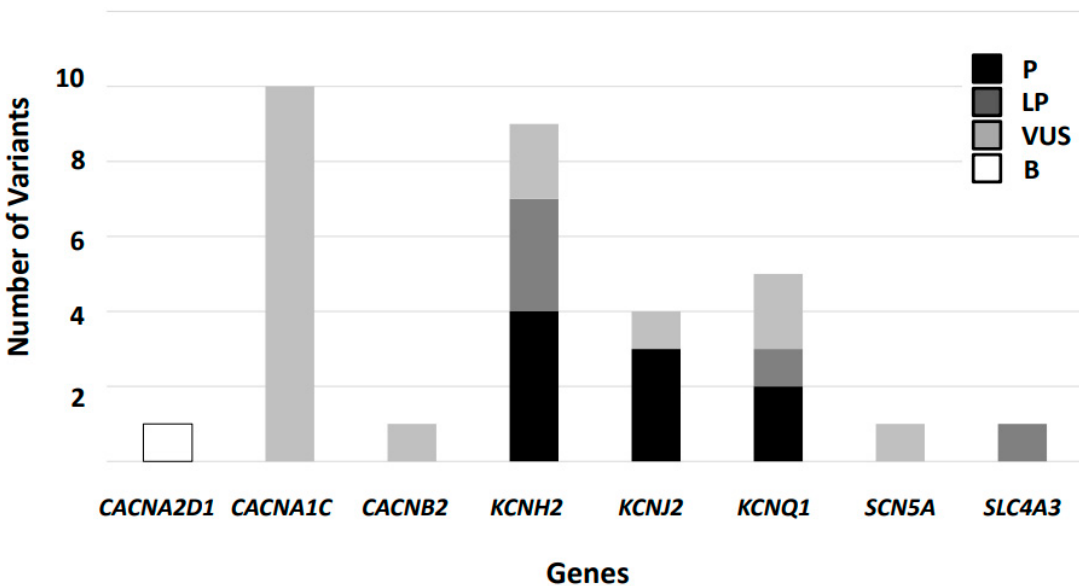
Figure 1. Classification of variants reported in Short QT Syndrome following American College of Medical Genetics and Genomics / Association for Molecular Pathology guidelines. Thirty-two variants were identified but only nine remains as definitively deleterious. P: Pathogenic, LP: Likely Pathogenic, VUS: Variant of Uncertain of Significance, B: Benign.